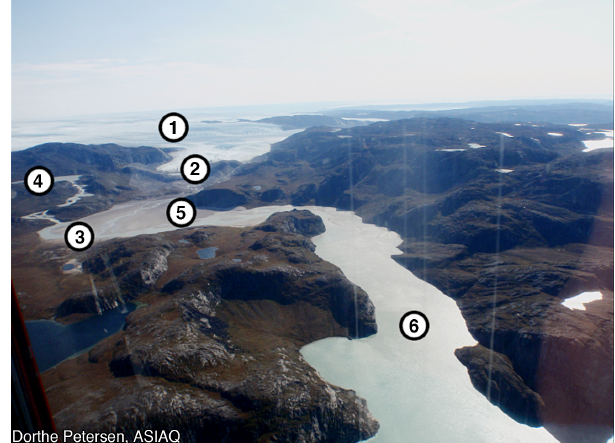
Figure 1. Conceptual diagram of processes that influence delivery of sediment from ice sheet to fjord, plotted on top of aerial photo- graph of the Pakitsuup south river and Pakitsuup fjord. Sediment produced subglacially may be stored until removed by water or ice (1). Once exported by the glacier (2), sediment can be trans- ported by rivers (3). While transported by the river, it can potentially be stored or passed through lakes (4), stored on the river’s outwash plain (5) until it is discharged into the ocean (6). Sediment stored on the river’s outwash plain may be remobilized at a later time by the river (5). Additional sediment can be sourced locally from the landscape, for example through bank erosion. Photograph courtesy of Dorthe Petersen,